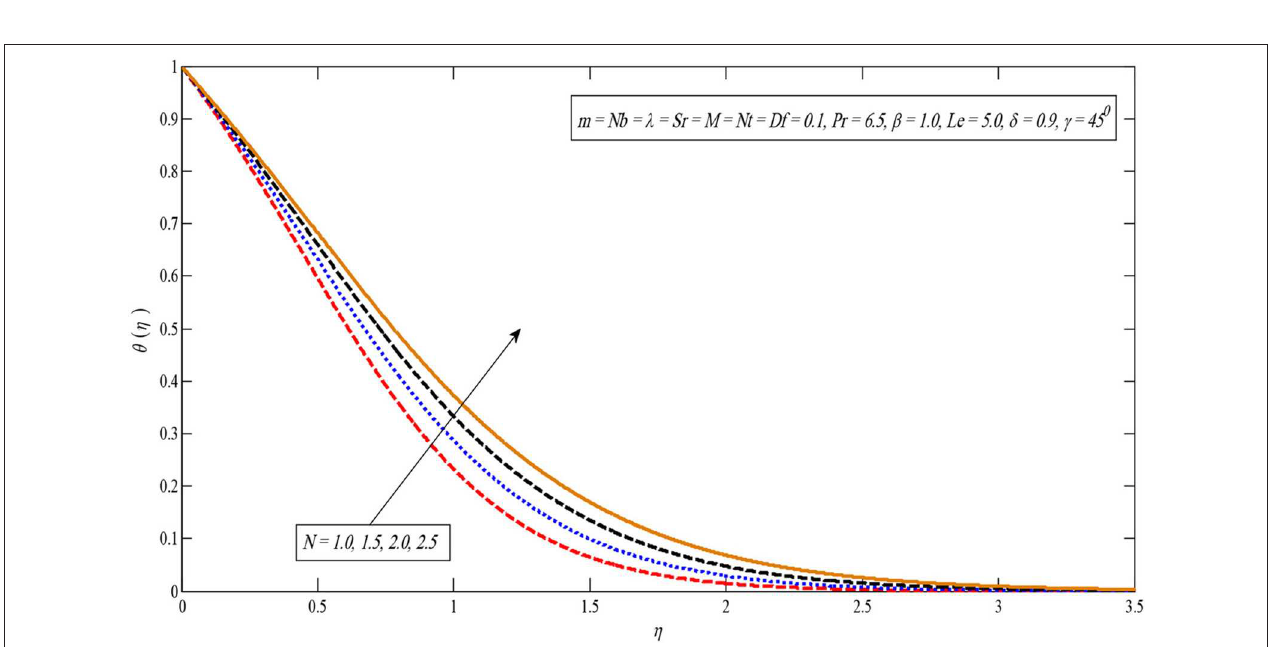
FIGURE 15 | Temperature profile for several values of N